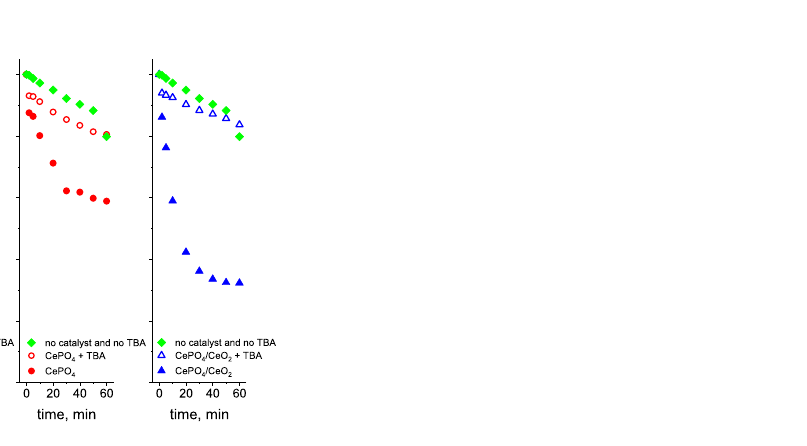
Figure 7. Influence of hydroxyl radical scavenger ( tert -butyl alcohol) on the efficiency of ozonation processes in the presence of chloride ions. Reaction conditions: 200 mL of BA solution (24 µM), initial ozone concentration: 120 µM, initial pH: 2.5, concentration of chloride ions: 3.22 mM, concentration of tert -butyl alcohol: 4 mM, catalyst loading: 0.2 g/L, room